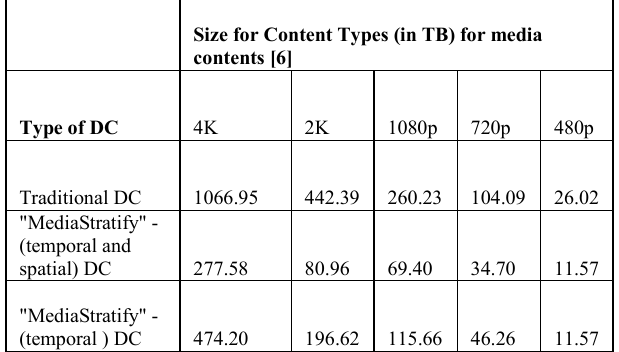
Table 1. File size description for a 90 minutes video file